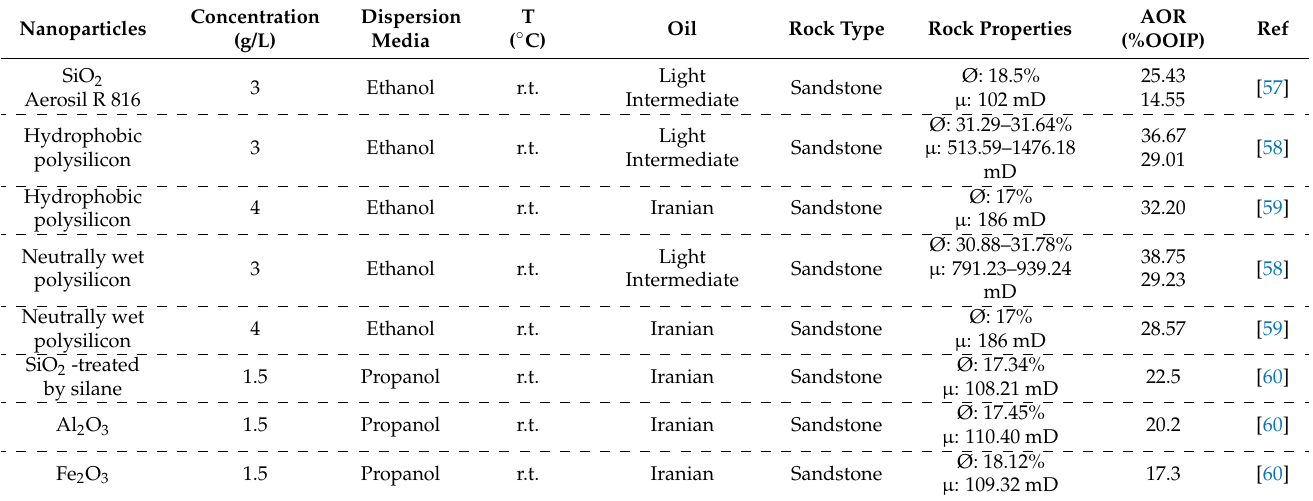
Table 3. Core-flooding tests involving nanoparticles and